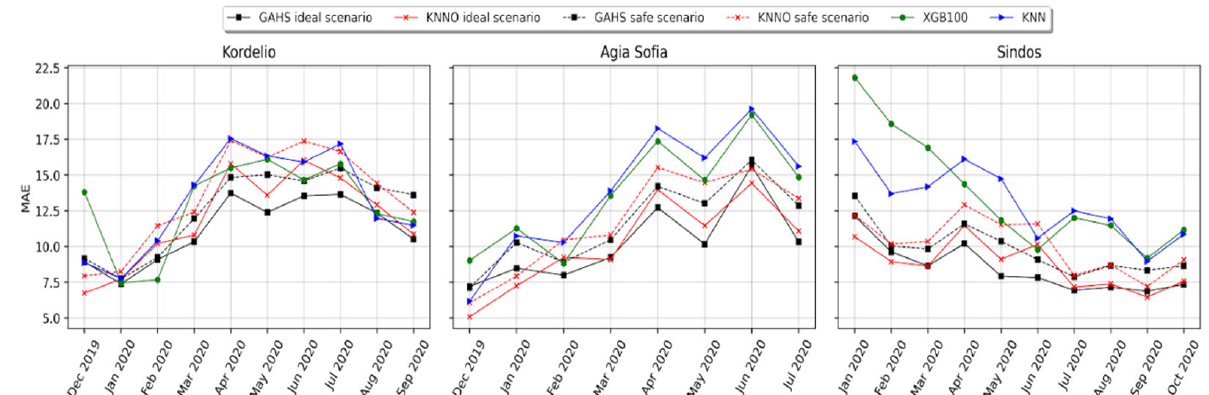
Figure 10. Comparison between the GAHS, and the SOL frameworks and the best performing batch models in terms of mean absolute error for O 3 .